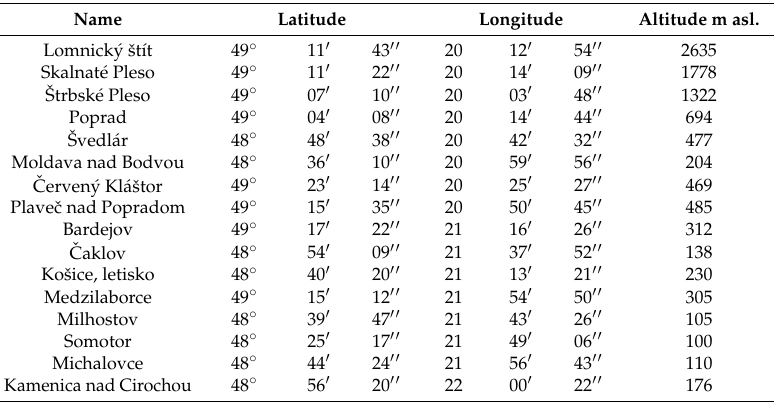
Table 1. Geographical location of climatic